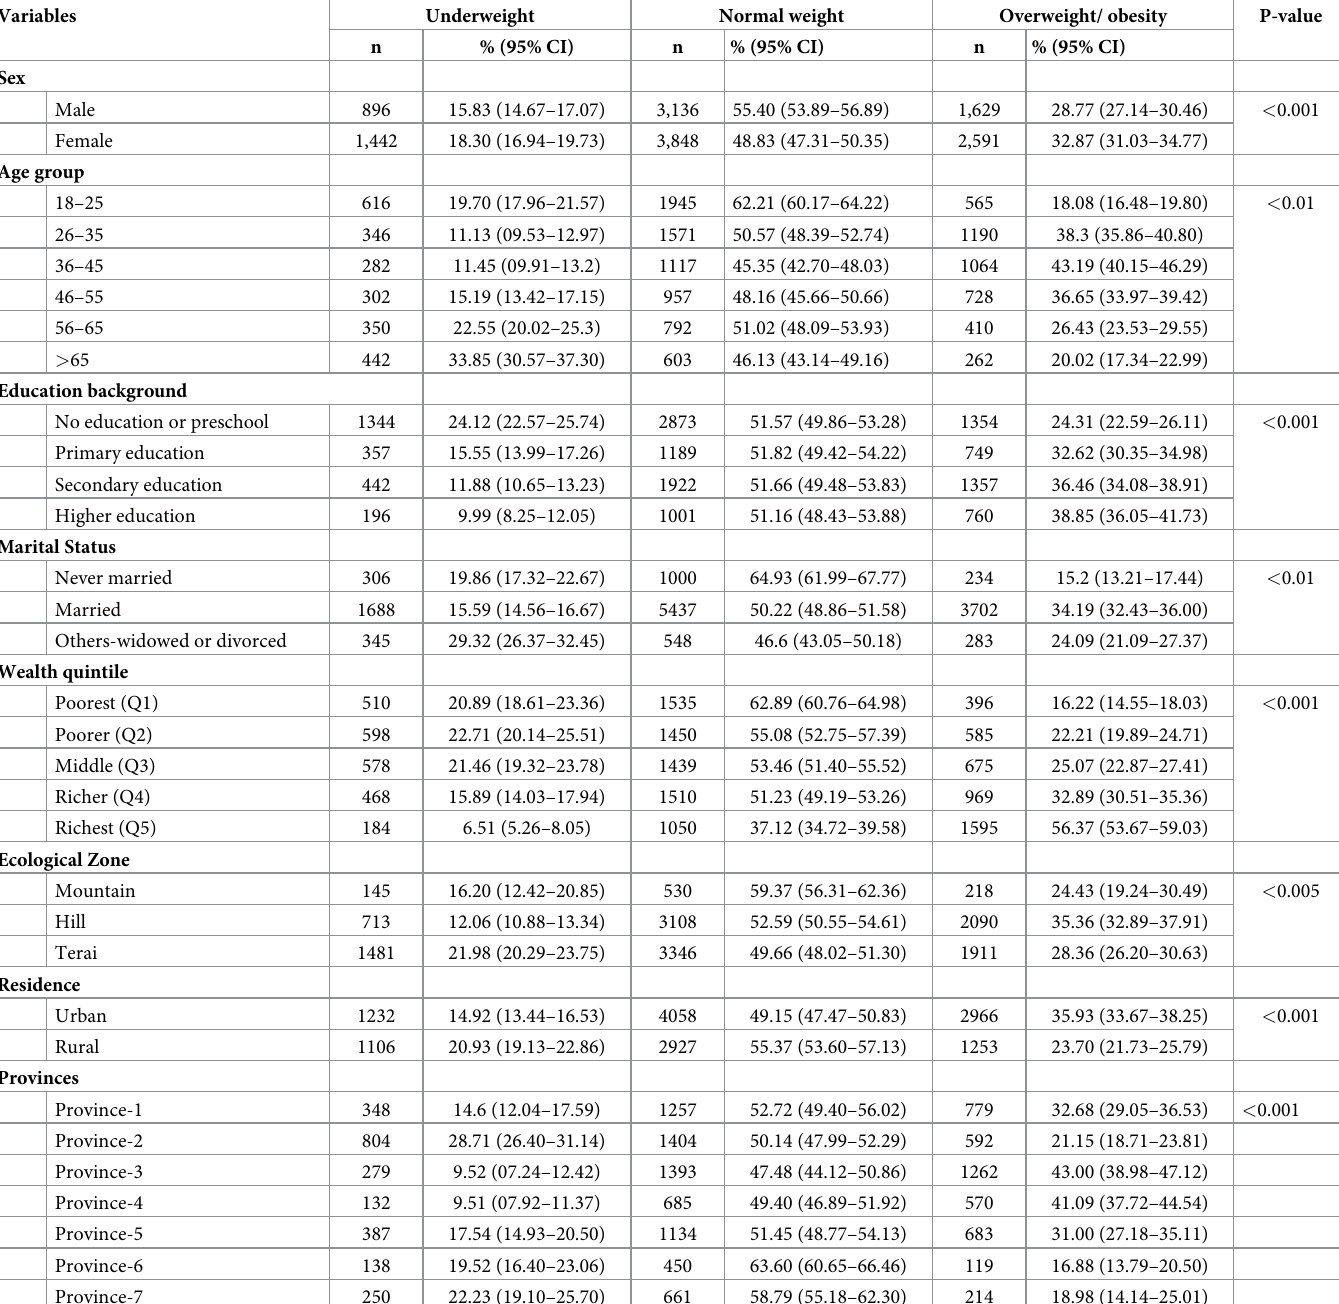
Table 2. Association between nutritional status and socio-demographic characteristics of study participants (N = 13,542) � .